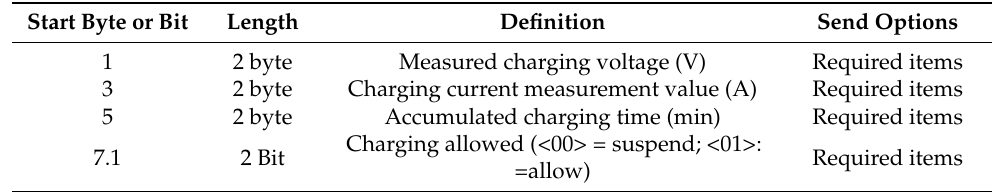
Table 4. Charger charge status message (CCS)